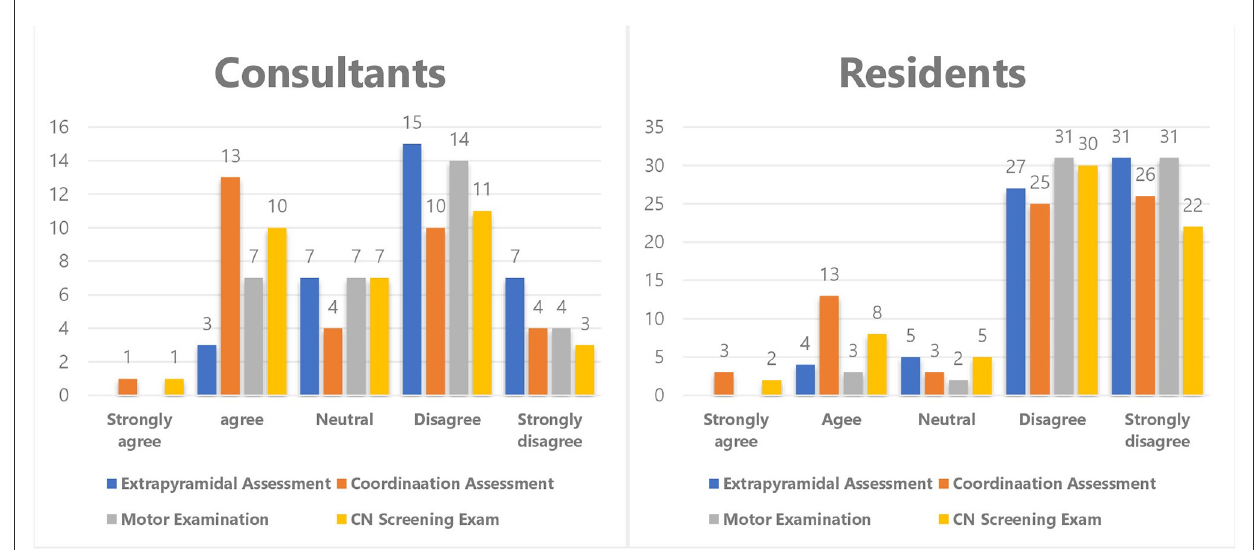
FIGURE1 Illustrates the comparison between neurology consultants and residents in performing extrapyramidal assessment, coordination assessment, motor examination, and CN nerve screening. There was statistically significant difference between the consultant and residents in performing these four duties with the consultants being more confident to perform them virtually than the